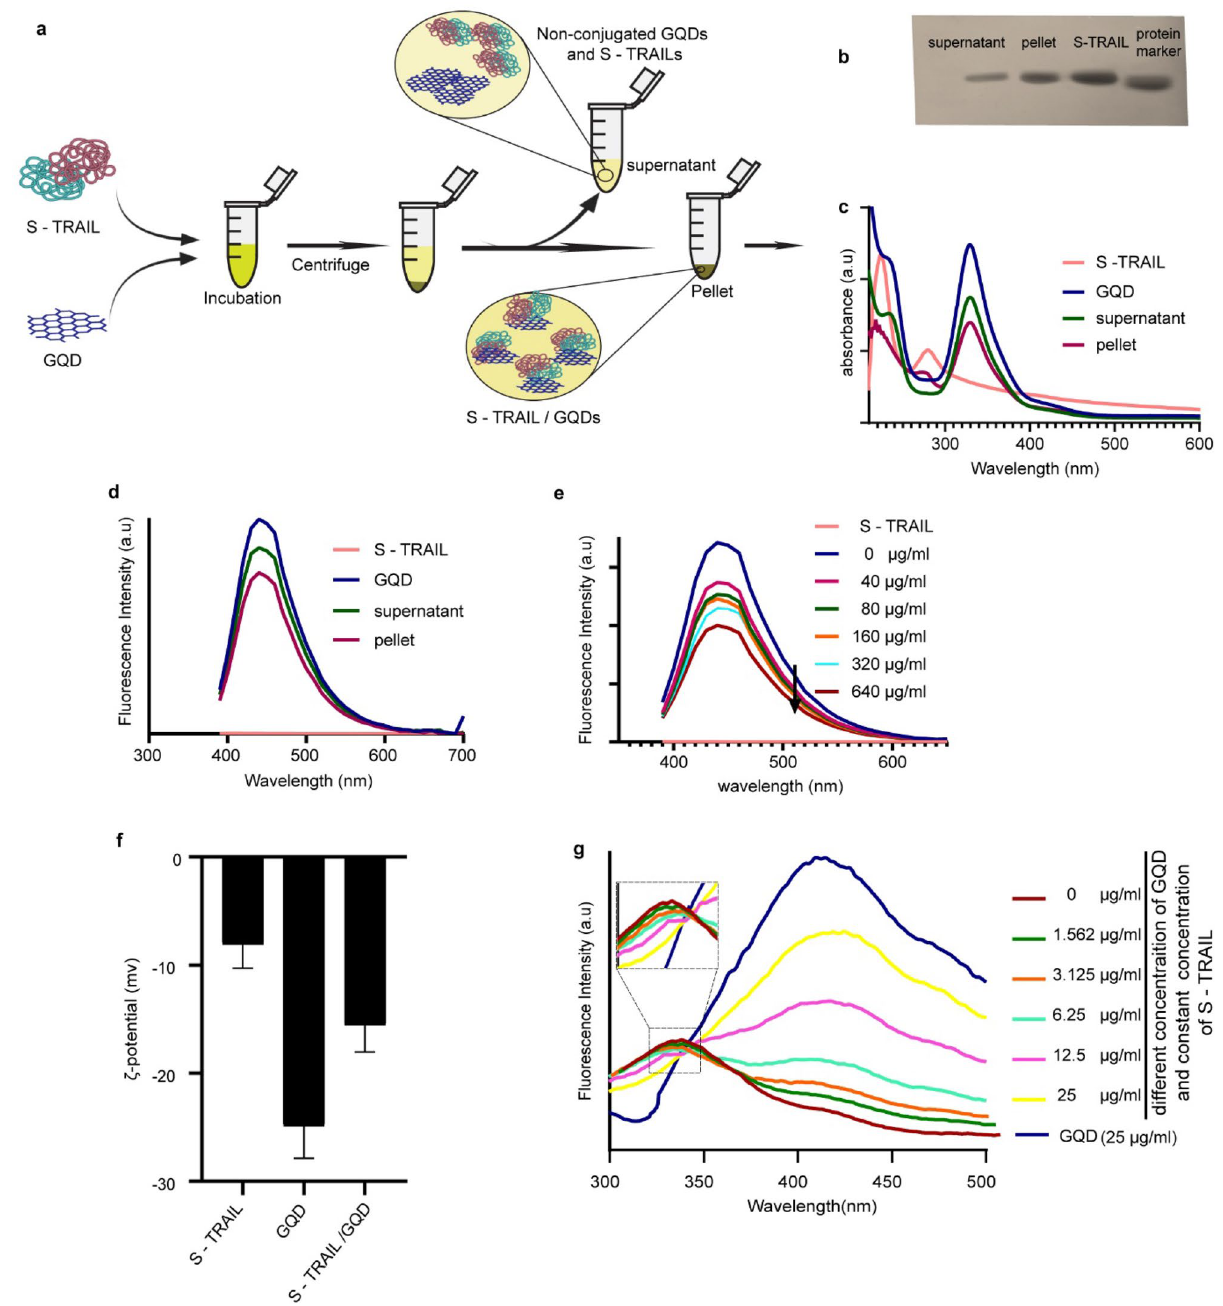
Figure 4. ( a ) Schematic illustration of S-TRAIL/GQD preparation steps. ( b ) Analysis of S-TRAIL content in centrifugation products (both supernatant and pellet) using polyacrylamide gel electrophoresis (12.5%), protein marker is 62KDa. ( c ) UV–visible spectra of S-TRAIL, GQDs and prepared S-TRAIL/GQD after centrifugation. ( d ) Fluorescence spectra of S-TRAIL, GQDs and S-TRAIL/GQD (pellet) and the supernatant upon excitation at 360 nm. ( e ) Fluorescence spectra of GQDs (6 µg/ml) in the presence of different concentrations of S-TRAIL upon excitation at 360 nm. ( f ) ζ-potential of S-TRAIL and GQD before and after conjugation. ( g ) Intrinsic fluorescence of S-TRAIL (160 µg/ml) in the presence of different concentrations of GQD upon excitation at 280